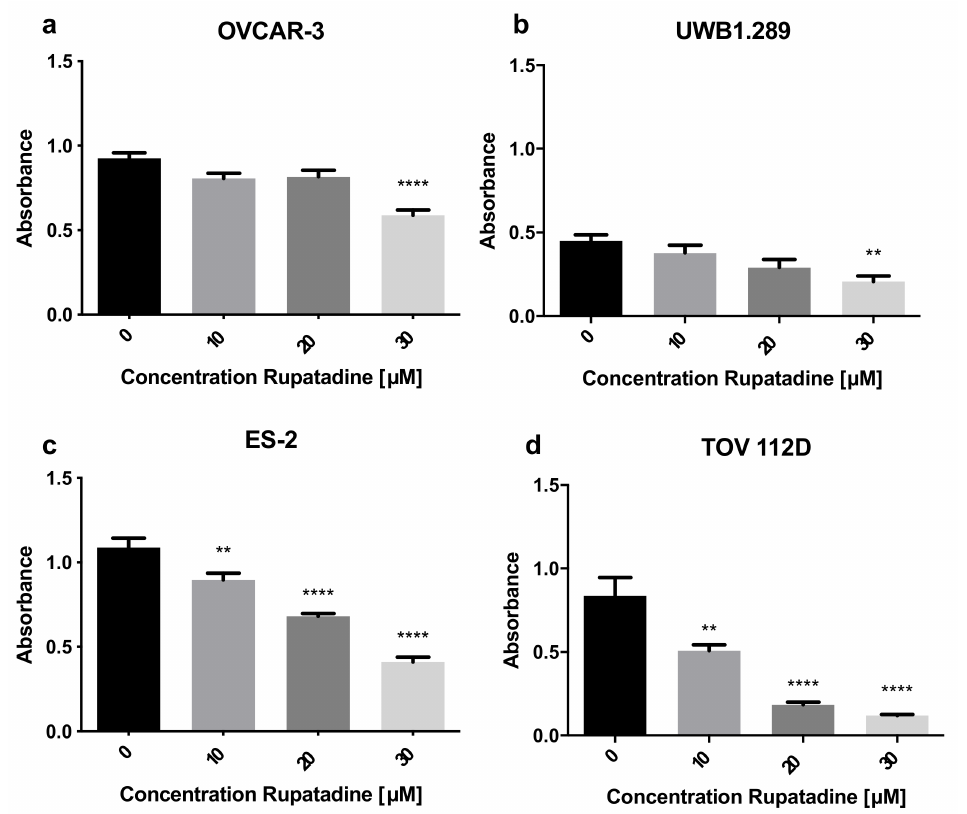
Figure 4. Rupatadine decreases proliferation of ovarian cancer cells. ( a ) OVCAR-3, ( b ) UWB1.289, ( c ) ES-2, and ( d ) TOV 112D were treated with increasing concentrations of rupatadine. Cell viabil- ity was tested with the MTT assay. All cell lines showed a concentration-dependent decrease in cell proliferation, with the greatest effect obtained with 30 µ M of rupatadine (( a , c , d ) p ≤ 0.0001, ( b ) p = 0.0021). In addition, 10 µ M and 20 µ M of rupatadine had a significant antipro- liferative effect in ( c ) ES-2 cells (control vs. 10 µ M of rupatadine, p = 0.0048; and 20 µ M of rupatadine, p ≤ 0.0001) and ( d ) TOV 112D cells (control vs. 10 µ M of rupatadine, p = 0.0016; and 20 µ M of rupatadine, p ≤ 0.0001). Results are represented as mean (SD) of 3 independent experiments. One-way ANOVA was employed to test for differences between groups and indicated as ** p ≤ 0.01 and **** p ≤ 0.0001 compared with controls. As a next step, we wanted to assess rupatadine’s influence on ovarian cancer cell migration. The wound healing assay was performed, showing significantly less cell migration in all cancer cell lines after 24 h compared to the control group (OVCAR-3: p = 0.0044, UWB1.289: p = 0.0261, TOV 112D: p ≤ 0.0001, and ES-2: p = 0.0145; Figure